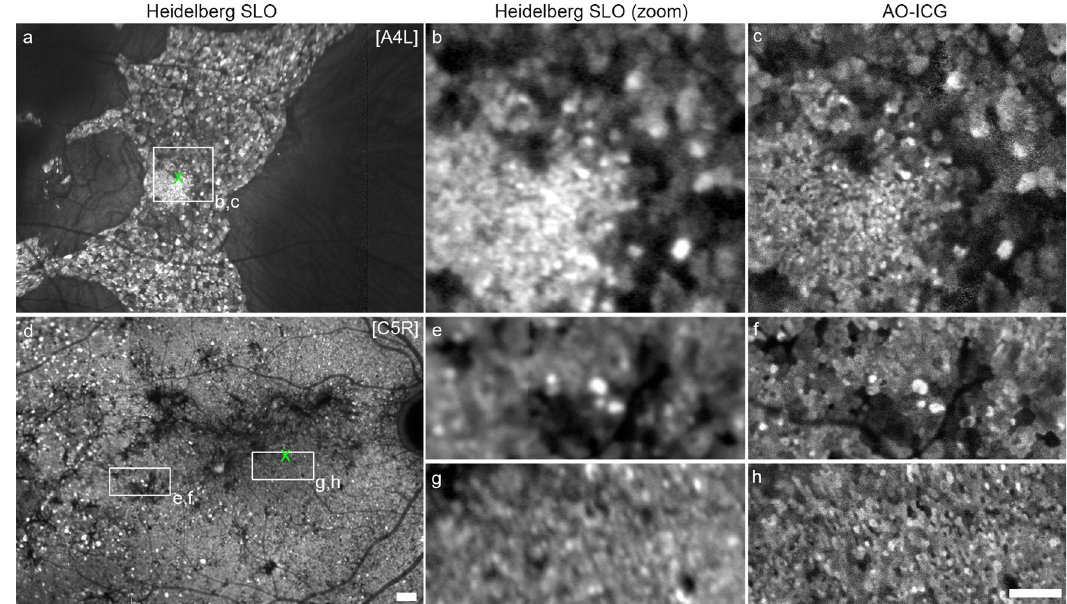
Fig. 5 Detection of RPE cell polymegathism using late phase ICG imaging. a Late phase ICG image acquired using a commercially available Heidelberg scanning laser ophthalmoscope (SLO) showing widespread enlarged RPE cells in an affected male. b Zoom of the white square in ( a ), contrast adjusted to show cellular detail. c AO-ICG image of the same region as ( b ). Many of the cells observed in ( c ) can be detected in ( b ). In the lower-left corner of ( b and c ), the RPE cells are smaller than those in the upper-right corner, but individual RPE cells are still visible. d Heidelberg SLO image from a female carrier. Numerous hyper fl uorescent enlarged RPE cells can be observed, especially near the left edges of the image. e , g Contrast-adjusted zoom of white rectangles. f , h AO-ICG images corresponding to ( e and g ) showing that the heterogeneous pattern of fl uorescence captured using the Heidelberg SLO matches the pattern imaged using AO-ICG. These side-by-side comparisons illustrate that individual enlarged RPE cells can be detected using conventional imaging, even without AO. a , d The green ‘ x ’ denotes the fovea. Scale bar, 1 mm. b , c , e – h Scale bar, 500 µ